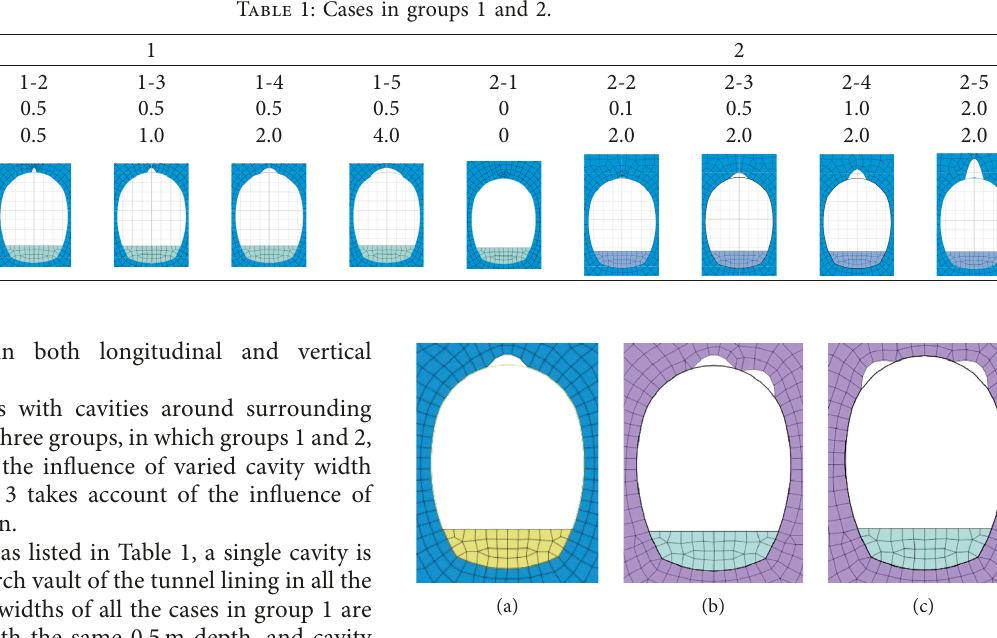
Figure 2: Cases in group 3. (a) Case 3-1. (b) Case 3-2. (c) Case 3-3.